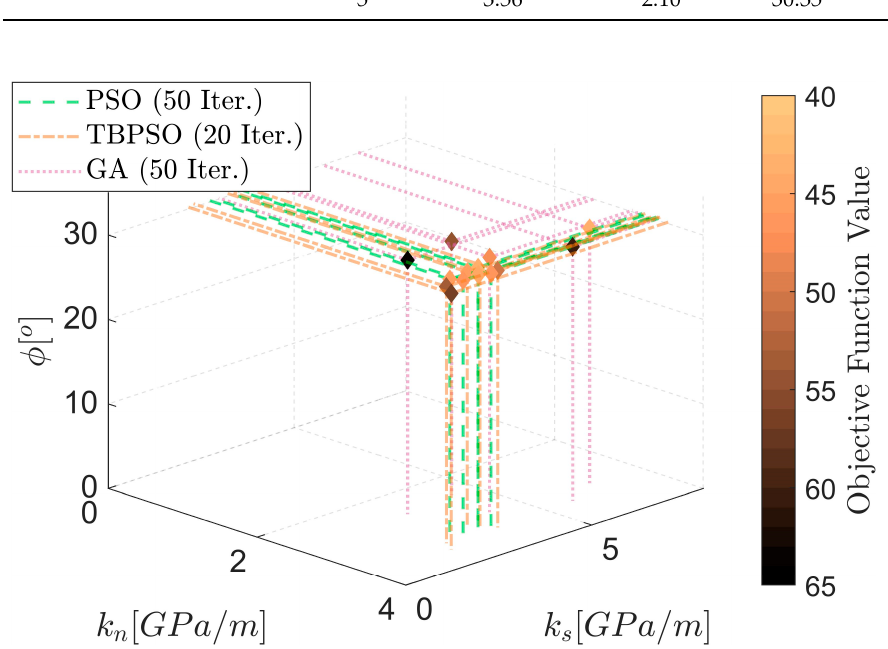
Figure 17. Position of calibrated material parameters of Pulatsu’s geometry (objective function 2, PSO and GA: 50 iterations; TBPSO: 20